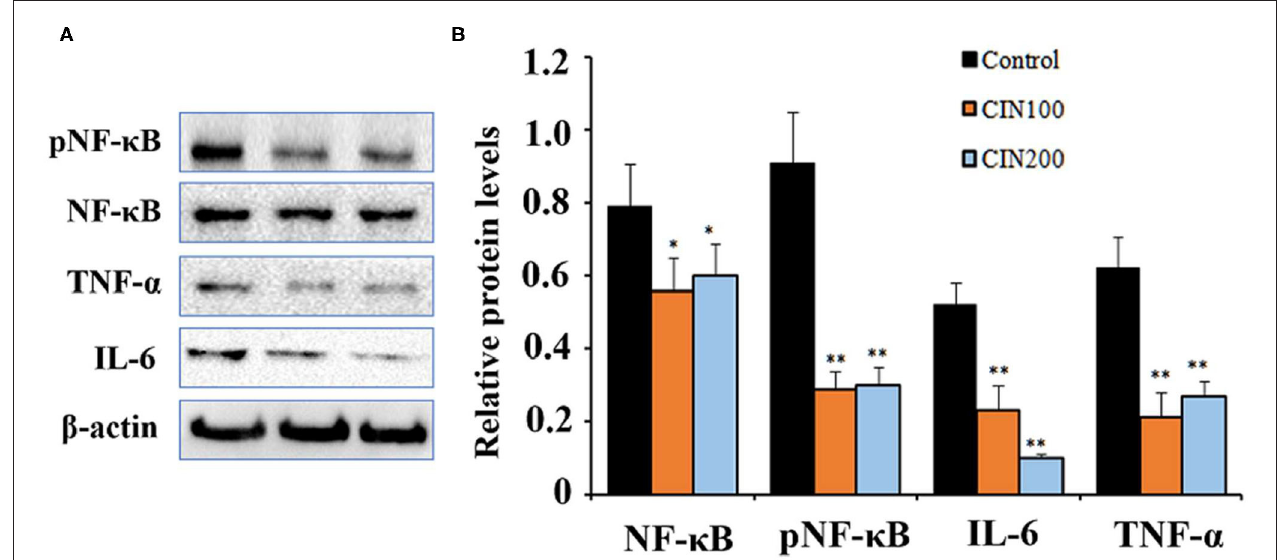
FIGURE 4 | Cinnamaldehyde supplementation inhibits the activation of NF- κ B in early weaned rat colon tissues. (A) Western blot analysis for NF- κ B, pNF- κ B and the downstreaming inflammatory cytokines. (B) Quantitative analysis for the densitometry of the proteins performed using ImageJ software. Data are expressed as mean ± SD. * P < 0.05, ** P < 0.01. One-way ANOVA was carried out for each comparison with HSD